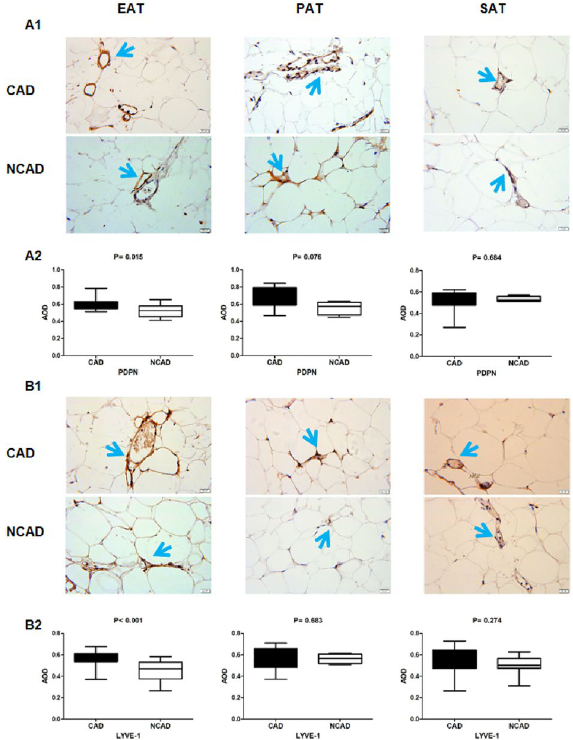
Figure 6. Immunohistochemistry detection of PDPN and LYVE-1 expression in adipose tissues. ( A1 ) Representative images of PDPN expression in EAT, PAT and SAT. ( A2 ) AOD of PDPN in EAT, PAT and SAT between CAD (n = 22) and NCAD (n = 15) patients. ( B1 ) Representative images of LYVE-1 expression in EAT, PAT and SAT. ( B2 ) AOD of LYVE-1 in EAT, PAT and SAT (n = 22). The Mann–Whitney U test was used to compare the relationship between the CAD and NCAD